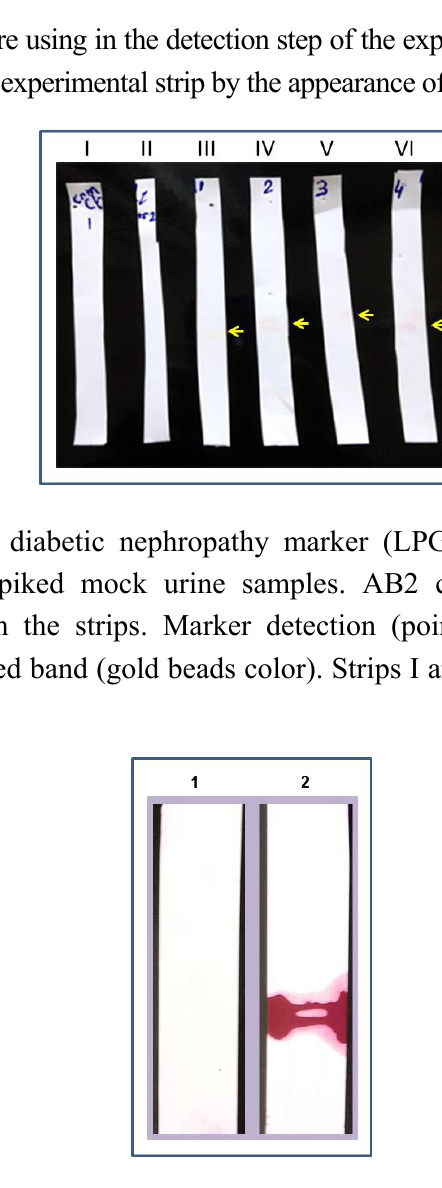
Figure 6. Enhanced detection of marker: AB1 coated strips are incubated in LPGDS (marker) spiked mock urine sample. AB2 coated nanogold beads prestained with Ponceau-S dye were allowed to interact with the strips, washed with water, and dried. Marker detection was confirmed by dark red band on the strip (Strip1 = Control (without marker); Strip 2= experimental (with